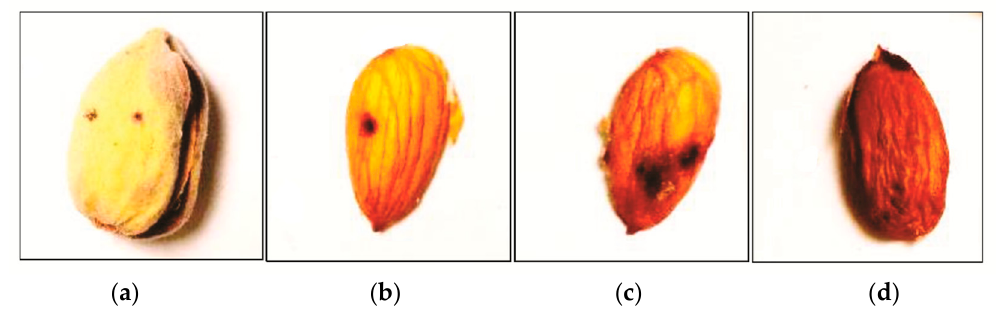
Figure 5. Four types of almond damage evaluated at harvest included ( a ) hull strikes, ( b ) nut strikes, ( c ) kernel necrosis, and ( d ) shrived kernels.